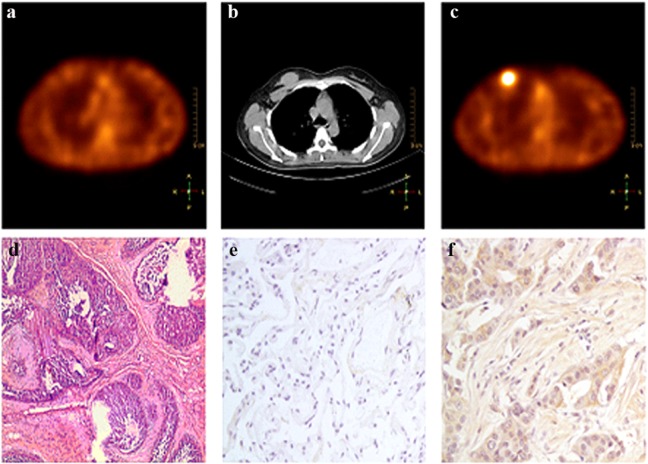
A 51-y-old patient with a breast malignant tumor in the right side as Patient 1 in Table 3; (a) 99mTc-3P4-RGD2 SMM demonstrates no tracer uptake observed in the lesion.(b) CT scan demonstrates a mass in the right breast. (c) 99mTc-RGD-BN SMM demonstrates high uptake observed in the lesion. (d) Histopathology staining indicated a ductal carcinoma in situ. ×40 (e) Immunohistochemistry demonstrates barely αvβ3 expression in tumor vessels and tumor cells. ×400. (f) Immunohistochemistry demonstrates intense GRPR expression in tumor vessels and tumor cells. ×400.